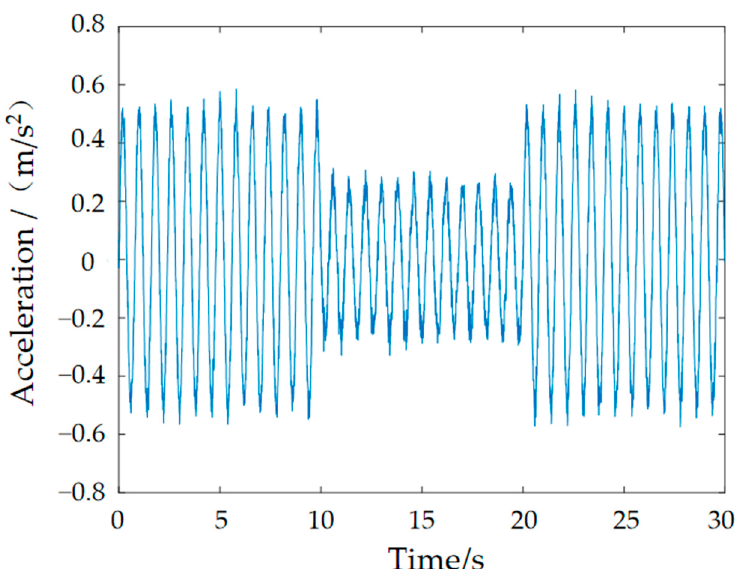
Figure 18. Block diagram of the control system.